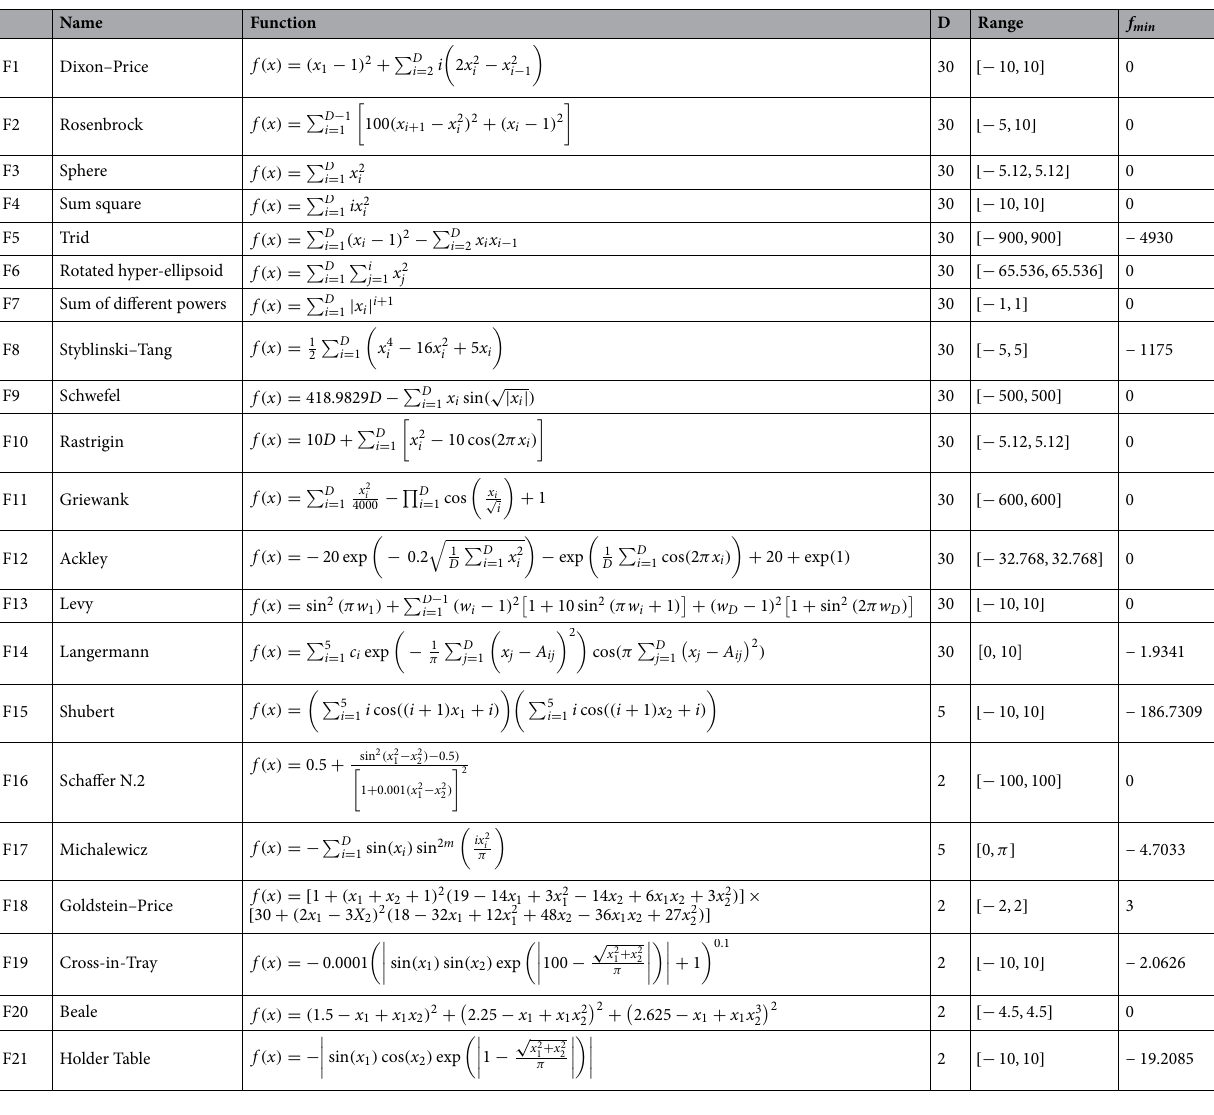
Table 1. Benchmark functions 27